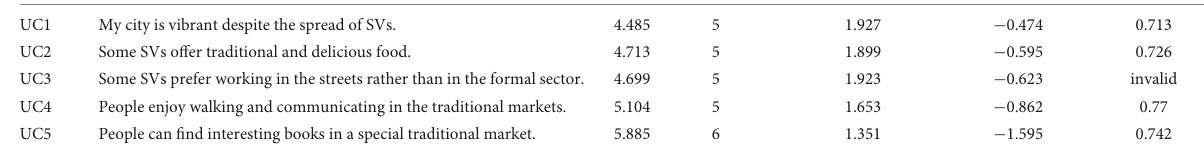
TABLE 6 Measurement properties of urban culture. Codes Items